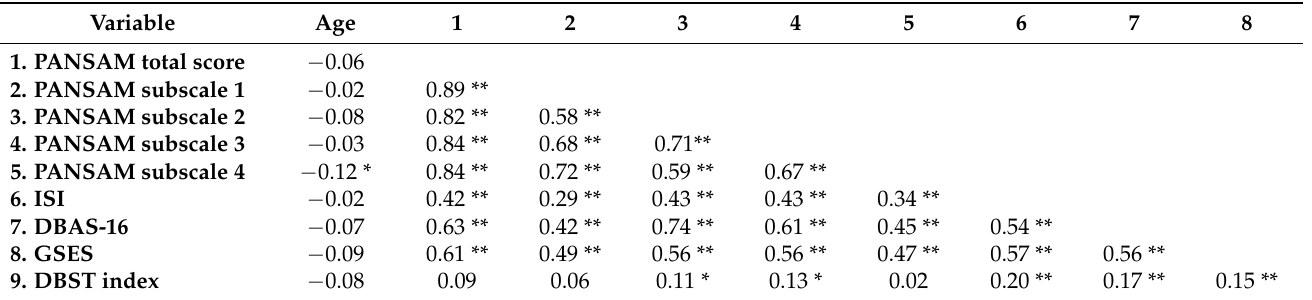
Table 5. Correlation coefficients of each variable in all